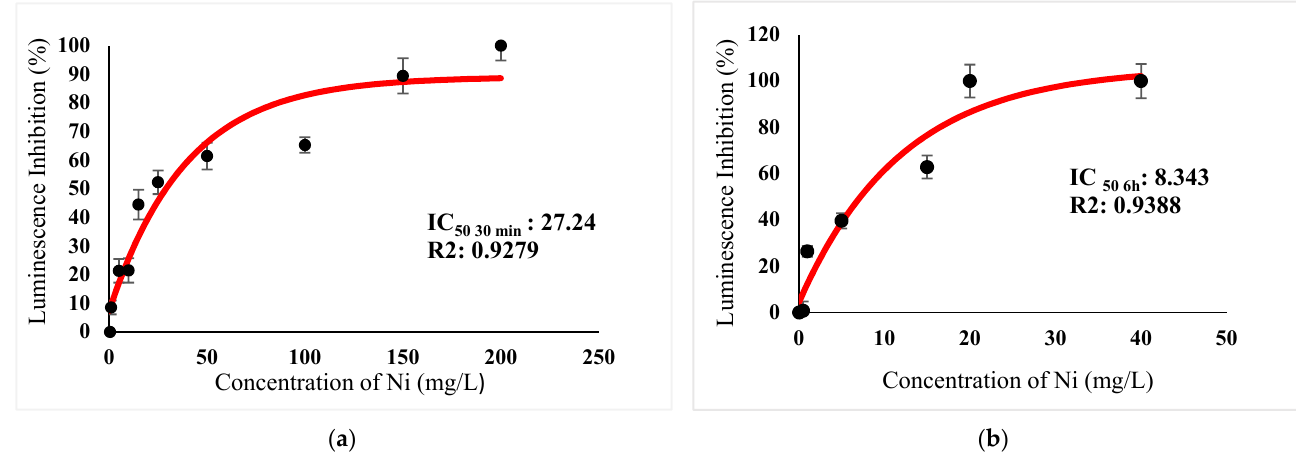
Figure 6. ( a ) Acute and ( b ) Chronic toxicity of Ni 2+ on luminescence inhibition of Photobacterium sp.NAA-MIE. Data represent mean ± SD, n = 3.